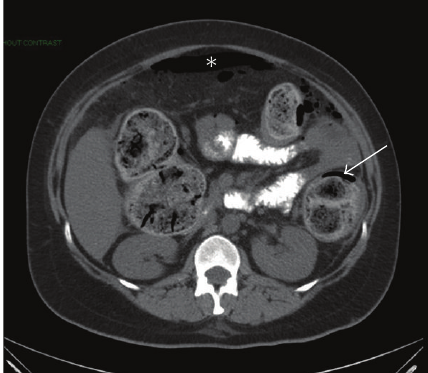
Figure 2: CT scan of the abdomen with free air (star) and air in bowel wall (arrow).